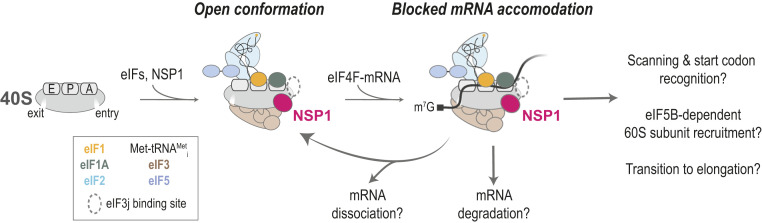
Proposed model. In the absence of eIF3j, NSP1 preferentially associates with the open conformation of the 40S subunit to block full accommodation of the mRNA in the entry channel, which inhibits translation initiation. How incomplete mRNA accommodation impacts mRNA recruitment, scanning, start codon selection, 60S subunit recruitment, and the transition to elongation remain open questions. Whether and how NSP1–40S subunit complexes lead to mRNA degradation is also unknown.